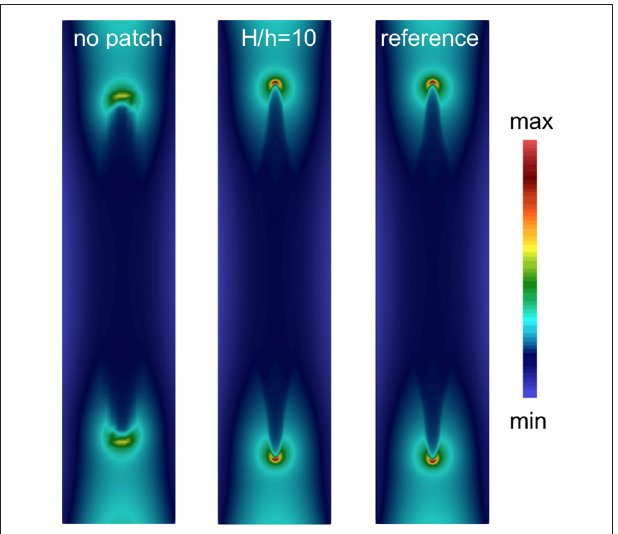
FIGURE 8 | Contour plots showing the rms electric field distribution at 110 ns without (Left) , with (Middle) patch H / h = 10 and for the reference case (Right) obtained in conditions of Figure 7 in the patched region. The color scale is between the minimum value of 2.38 MV/m and the maximum value of 5.05 MV/m (the scale is normalized for the three